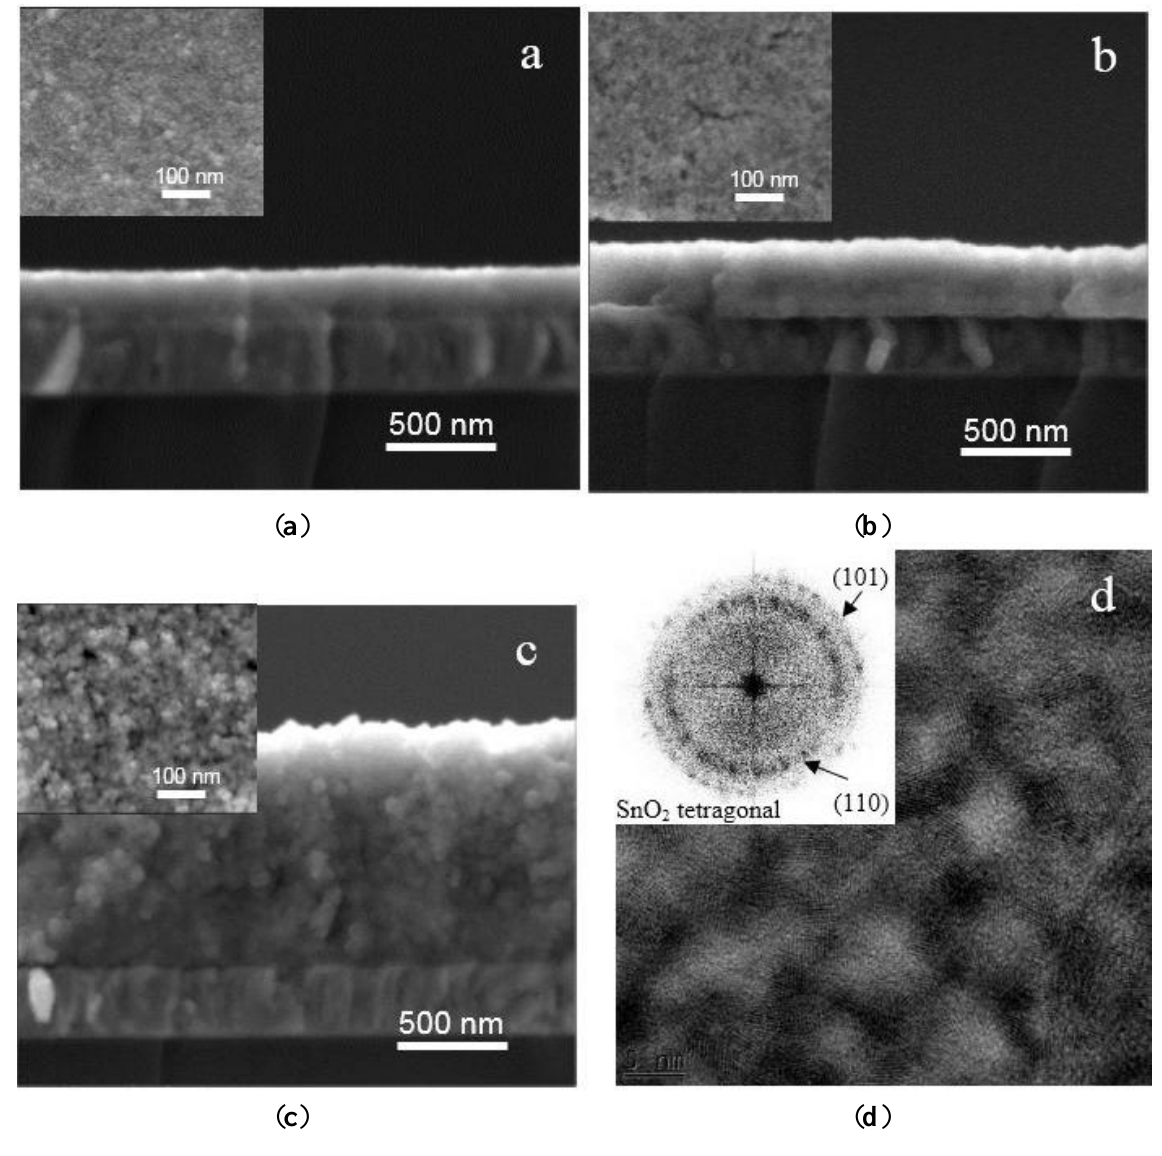
Figure 1. SEM images of SnO 2 films deposited onto ITO substrate at −1.0 V ( vs. Ag/AgCl) with charge density (Q) of ( a ) 0.2; ( b ) 0.4 and ( c ) 0.8 C·cm −2 ; ( d ) Typical cross-section HRTEM image of the film deposited with Q of 0.8 C·cm −2 . Inset shows the corresponding SAED